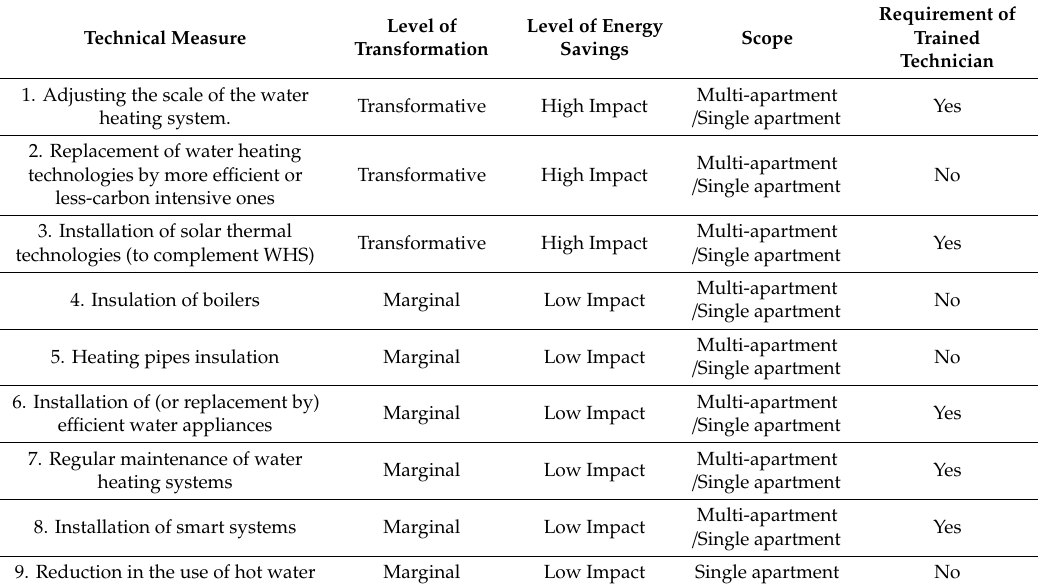
Table 3. Characterization of the technical